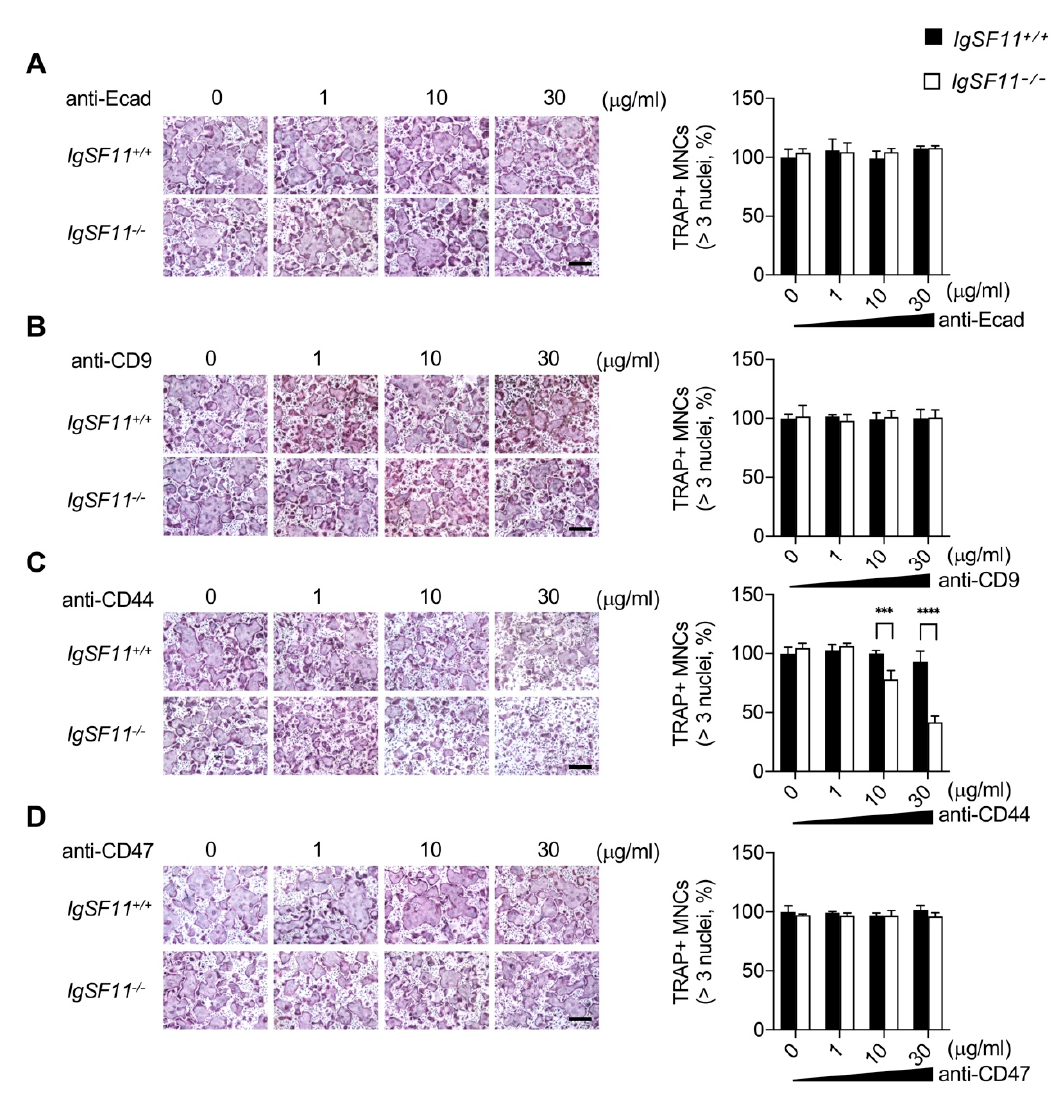
Figure 1. Blocking CD44 inhibits osteoclast differentiation of IgSF11-deficient cells in high-cell-density cultures. High-cell-density cultures of IgSF11 +/+ and IgSF11 − / − BMMs were treated with the indicated doses of soluble antibodies ( A ) anti-E-cadherin, ( B ) anti-CD9, ( C ) anti-CD44, and ( D ) anti-CD47, and cultured with M-CSF + RANKL for three days to induce osteoclast differentiation. On day three, cells were fixed and stained with TRAP (left). TRAP + multinucleated cells (three nuclei or more per cell) were counted and the frequency of TRAP + multinucleated cells is shown (right). Scale bars represent 100 μ m. Data are shown as the mean ± S.D. *** p < 0.001, **** p < 0.0001.